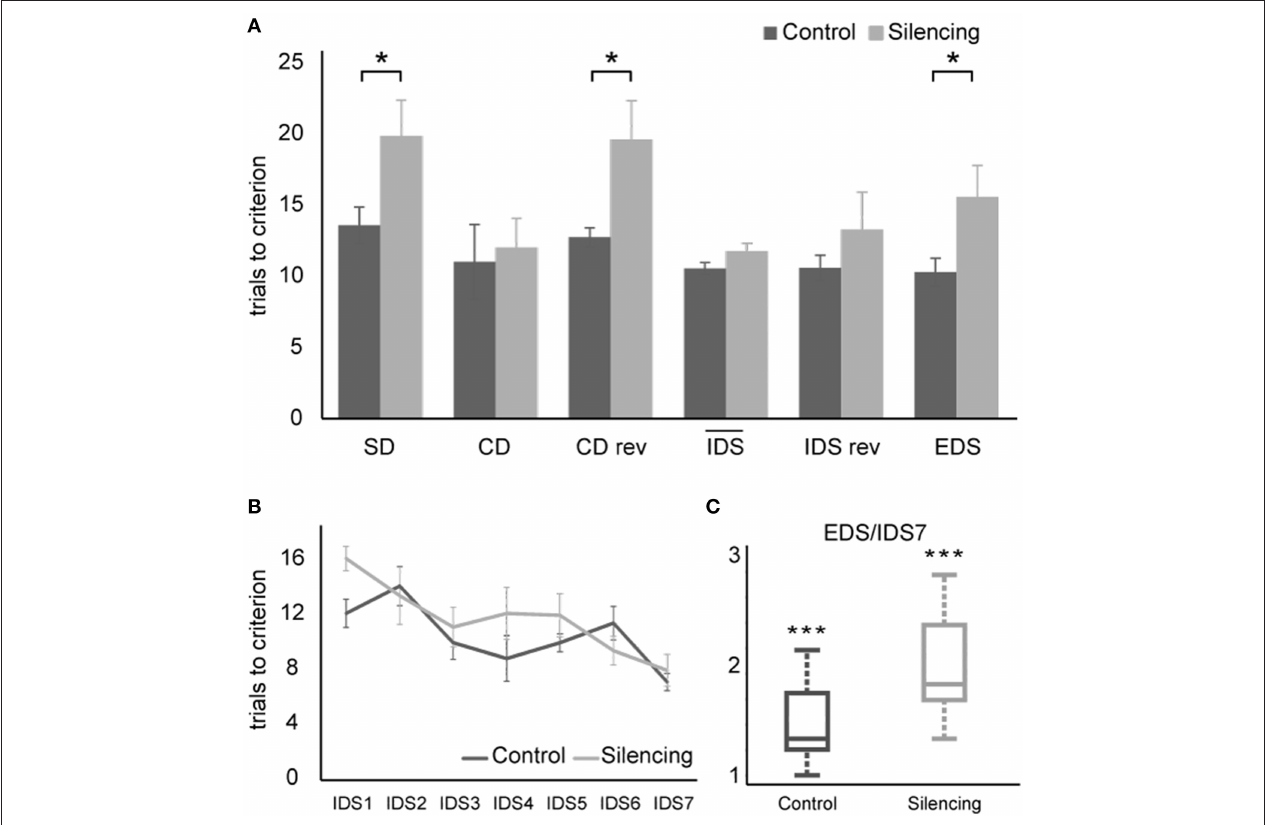
FIGURE 4 | Results of ASST. (A) Average trials to criterion for simple discrimination (SD), compound discrimination (CD), compound discrimination reversal (CDrev), the mean across all seven intra-dimensional shifts (IDS), reversal of the last intra-dimensional shift (IDS VIIrev) and extra-dimensional shift (EDS). SD, CDrev and EDS were significantly impaired by optogenetic silencing. Due to the increased number of IDS stages in our paradigm, they were plotted separately in (B) . Average trials needed to criterion for all seven IDS conditions. Overall, the trials needed to reach criterion decreased over subsequent IDS conditions, indicating set formation. (C) Quotient between performance in the EDS and the IDS VII reflecting attentional “shift cost” after successful set formation. Values exceed unity significantly for both control group and silenced group, demonstrating that silencing did not interfere with set formation and that both groups successfully formed an attentional